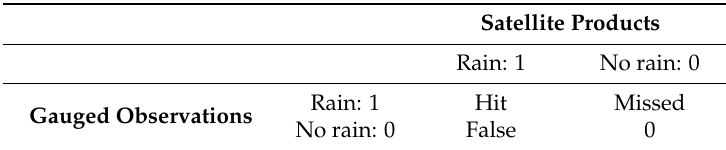
Table 2. Contingency table showing how three independent error components (hit, missed, and false) are identified by dichotomous variables (satellite products and ground